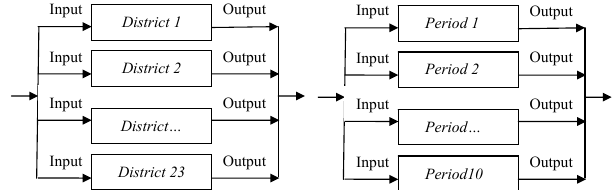
Fig.6. The economic density (left panel) and population density (right panel) in Dongting Lake region